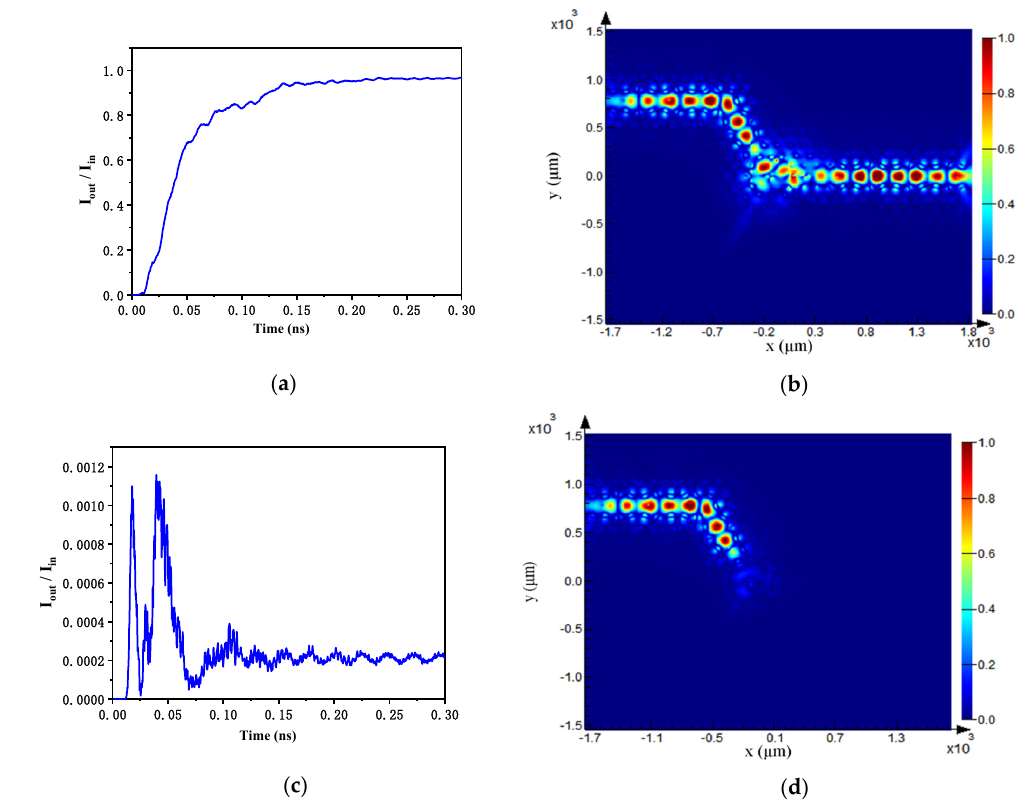
Figure 5. Port A as the input port. The time domain steady − state response ( a ) and steady − state field distribution ( b ) without pump excitation, and the time domain steady − state response ( c ) and steady − state field distribution ( d ) with pump excitation.